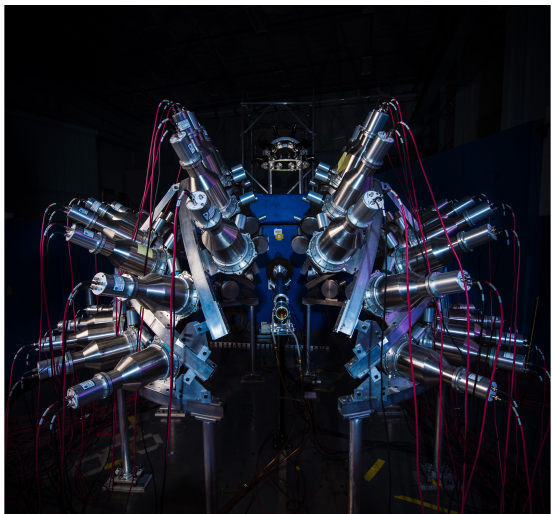
Figure 1: The Chi-Nu 54-detector liquid scintillator array is shown in the center of this image. The Li-glass array used in separate a experiment is seen above the shielding walls in the upper center of this